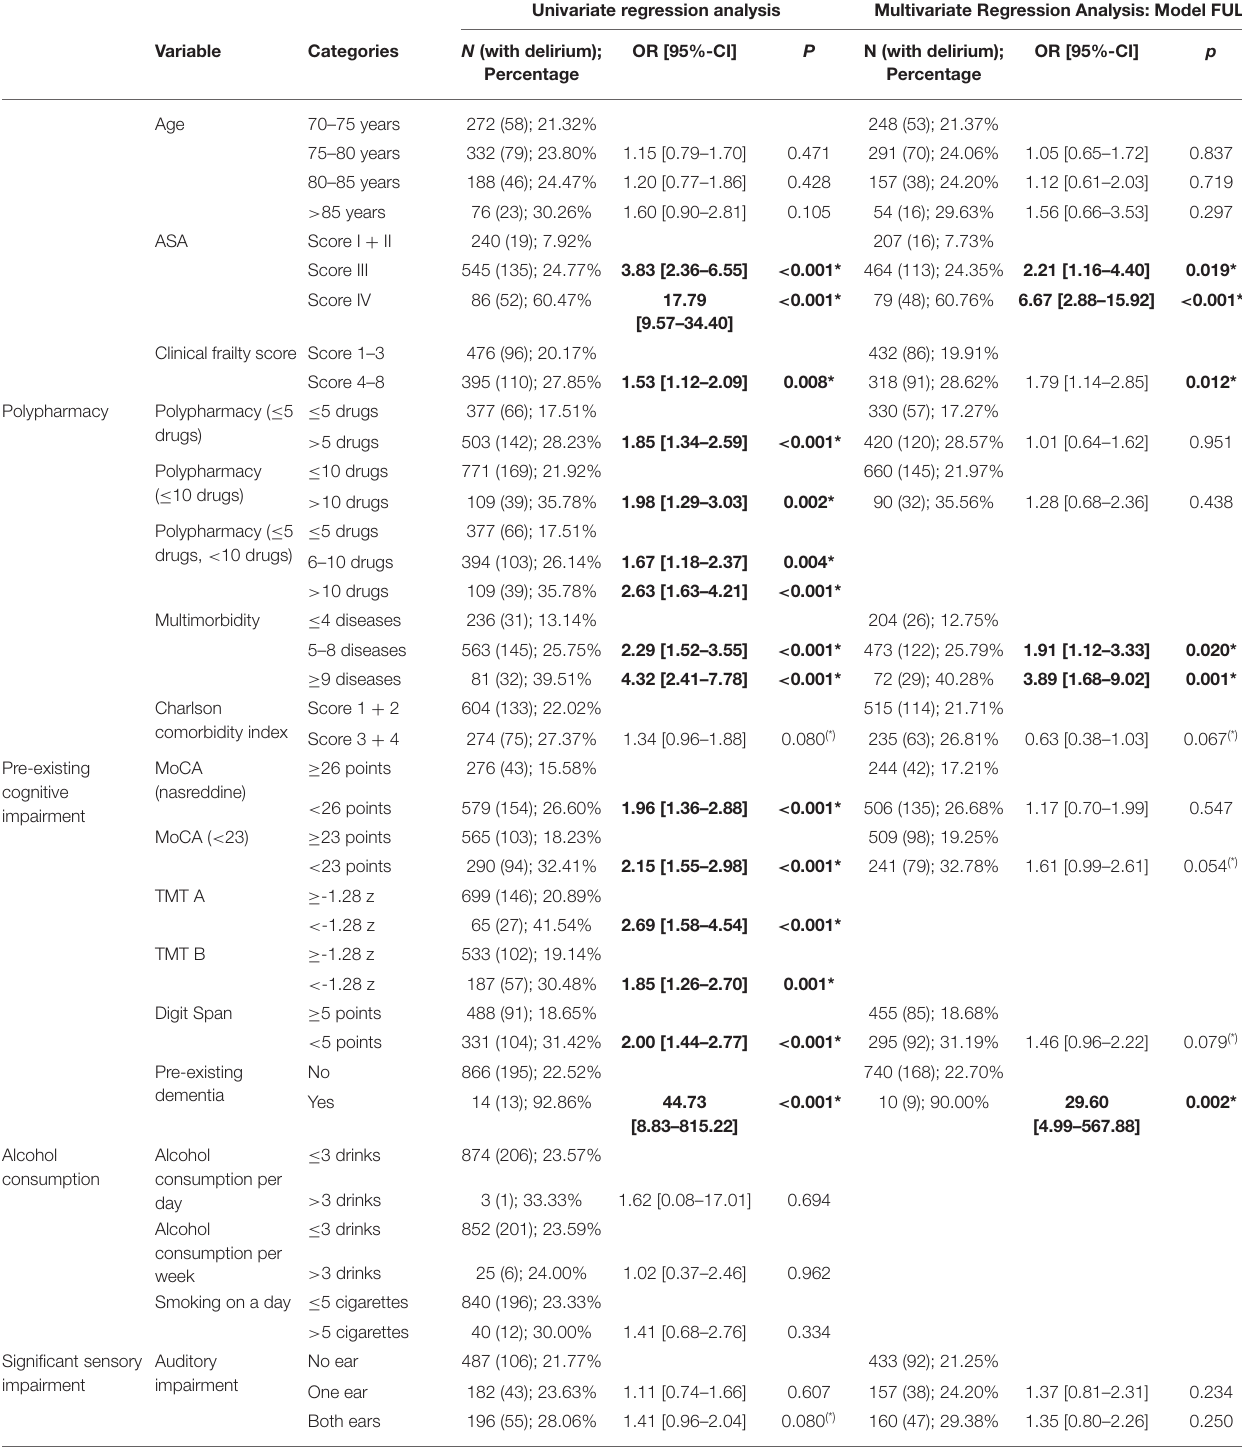
TABLE 3 | Univariate and multivariate logistic regression analysis (FULL model). Univariate regression analysis Multivariate Regression Analysis: Model